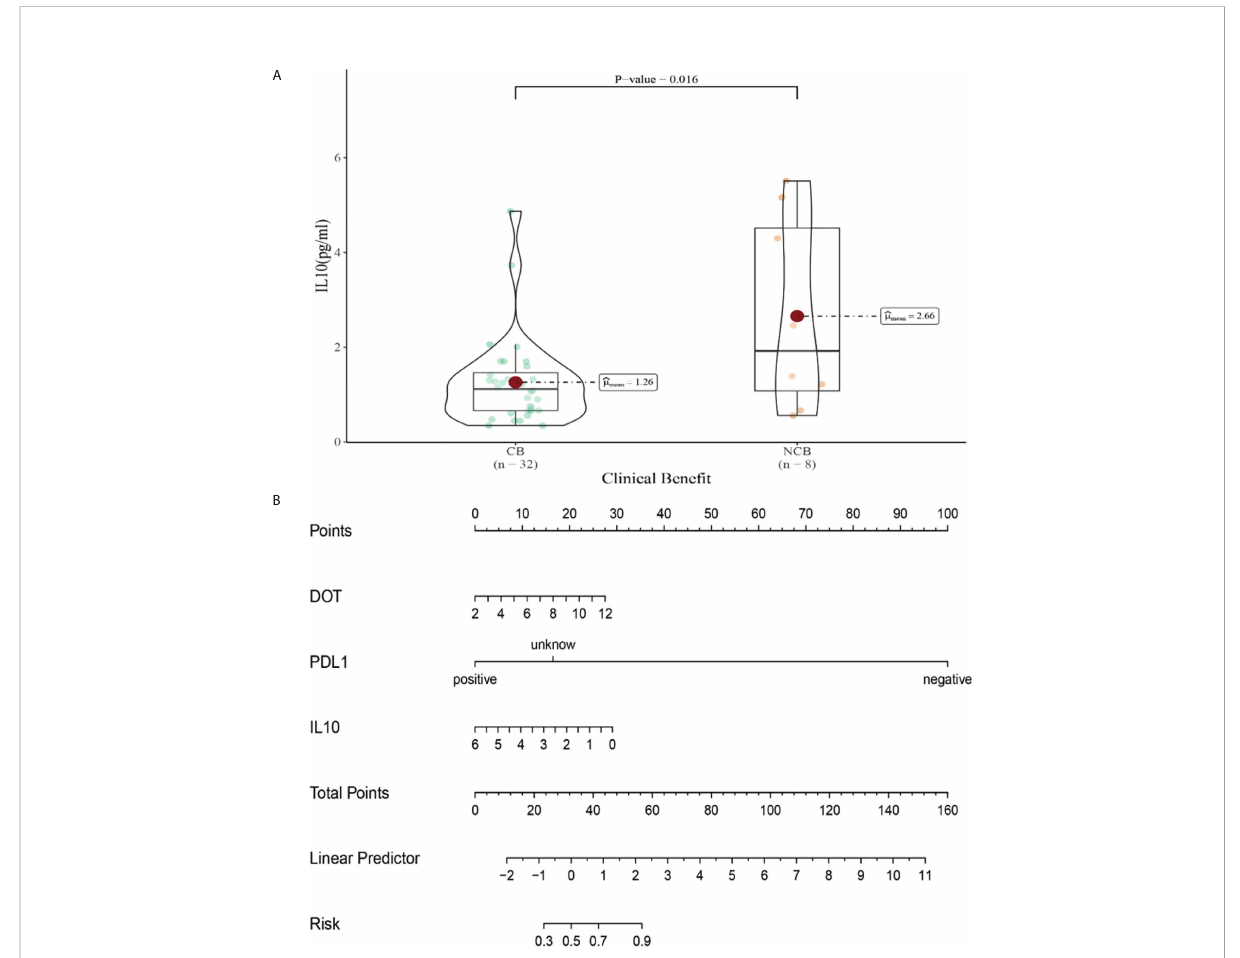
FIGURE 10 (A) Differences in IL-10 levels after the second cycle therapy between CB and UCB; (B) The nomogram based on logistic multivariate